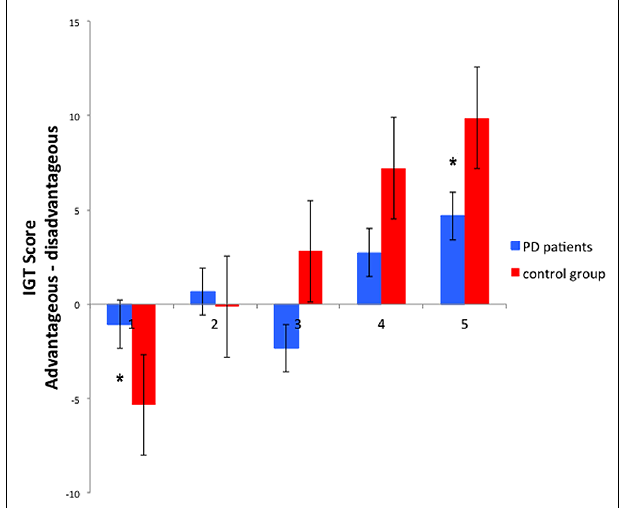
FIGURE 1 | Behavioral results of the Iowa gambling task: learning IGT scores in the five blocks, of PD patients and control group. *Significant difference refers to a p value < 0.05. Error bars represent standard